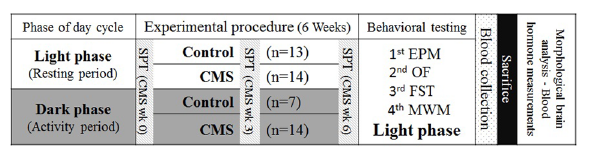
FIGURE 1 | Experimental timeline. Rats were housed in different light phases and the CMS protocol was applied to both CMS groups at the same time. Behavioral tests were performed, in the order shown (third column), immediately after the CMS protocol (6 weeks), during the daily period of the light-dark cycle. SPT, sucrose preference test (at 3 time points); EPM, elevated plus maze; OF, open field; FST, forced swimming test; MWM, Morris water maze. Morphological and blood hormone analysis were performed after the